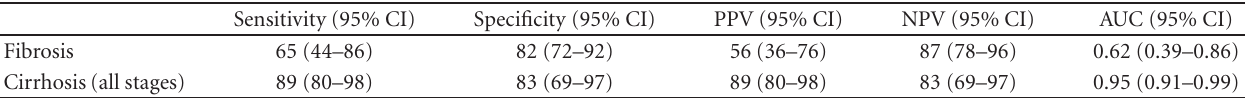
Table 3: Predictive value of the 13 C-MBT in various stages of liver disease based on the cumulative recovery of oxidation at 40